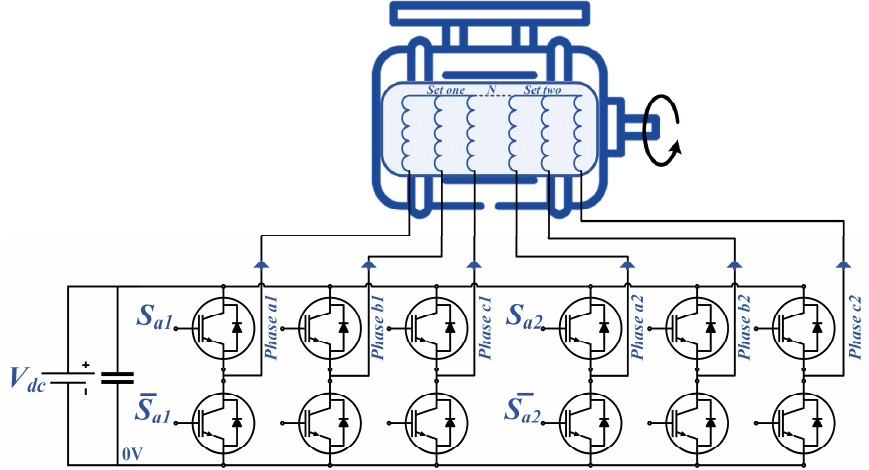
Figure 16. Two-level converter topology for a six-phase voltage source drive.